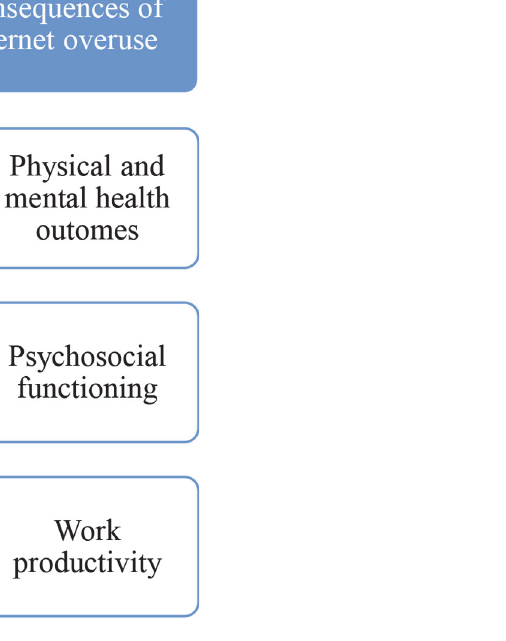
Figure 1. Diagram of Qualitative Themes and